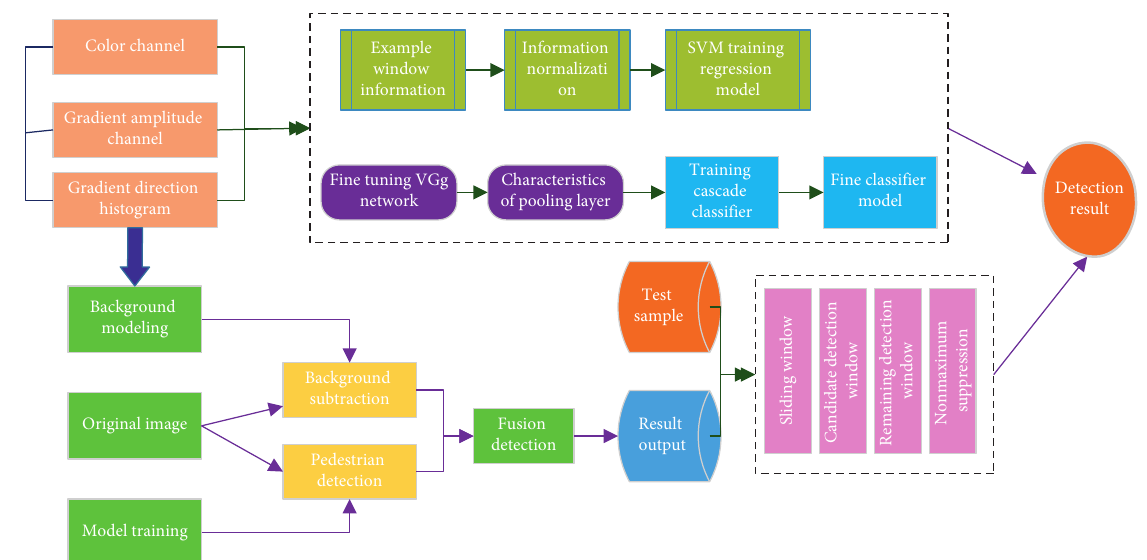
Figure 1: Flow chart of fusion detection